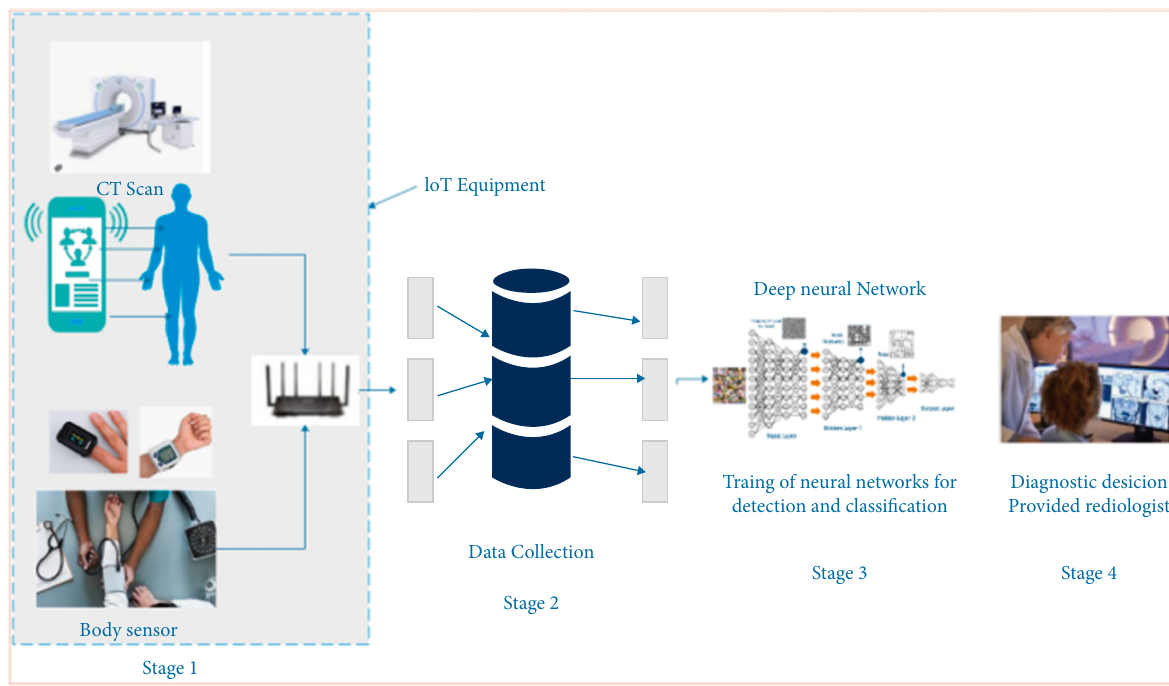
Figure 1: Detection of lung cancer by blockchain facilities [10].